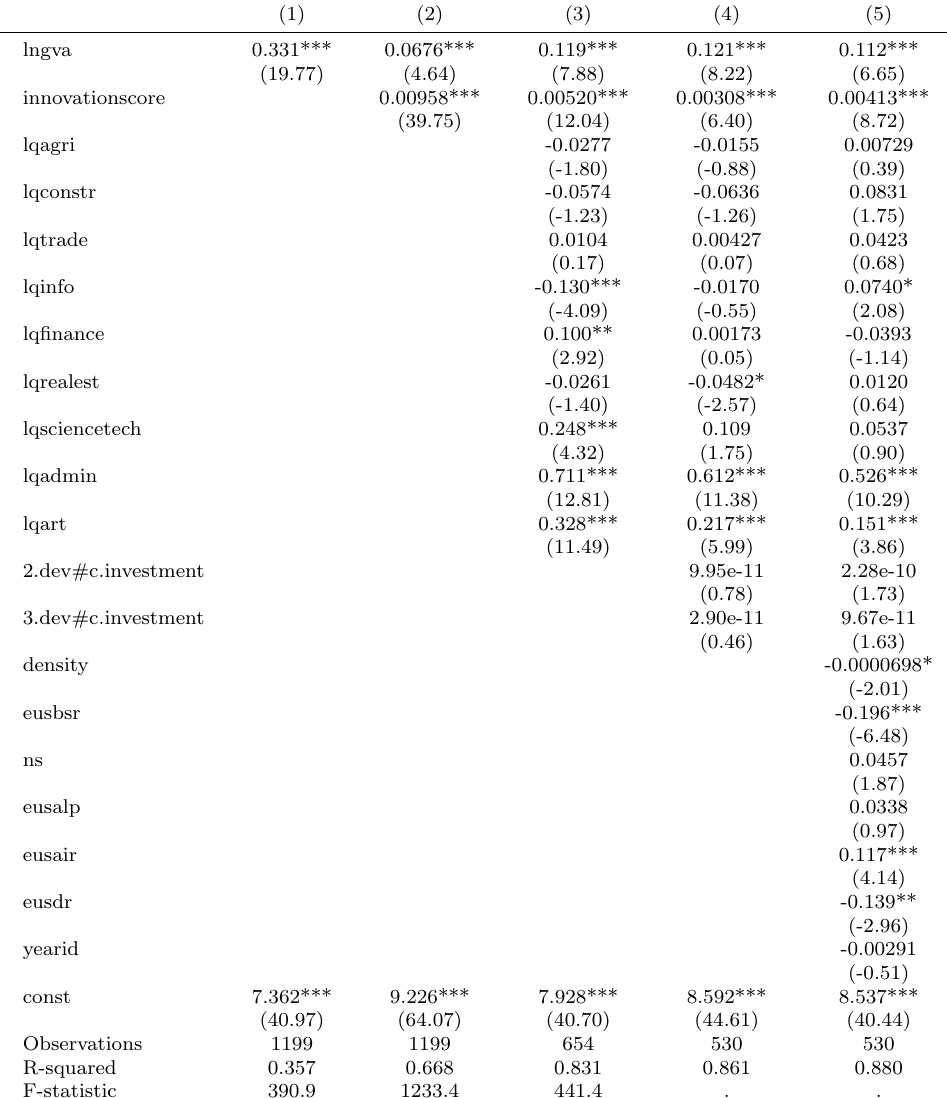
Table 3: Regression